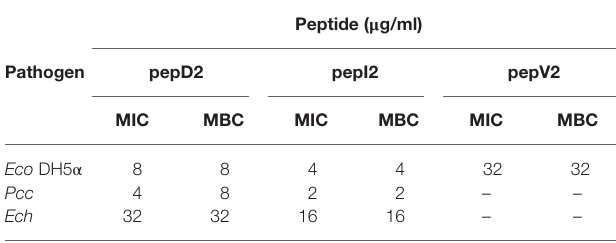
TABLE 6 | MICs and MFCs of the fatty acyl-modified peptides against phytopathogenic fungi.